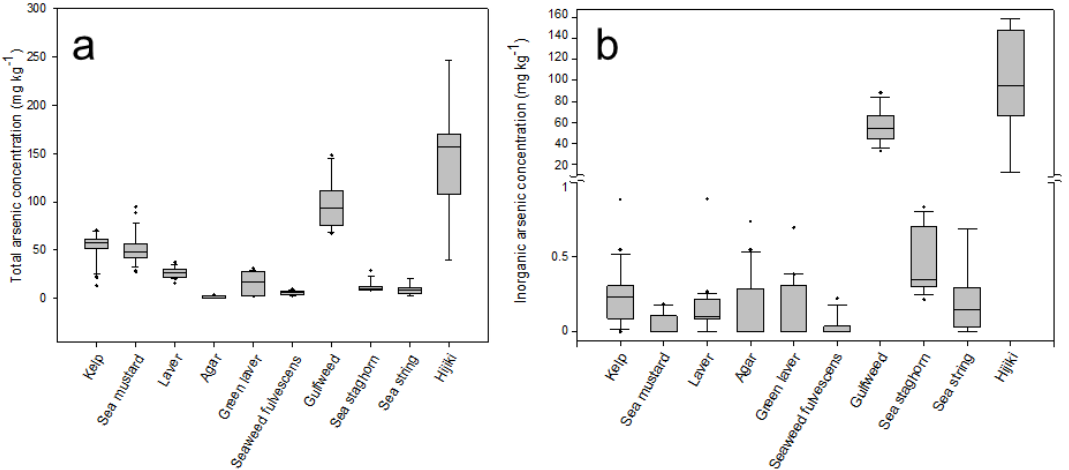
Figure 2. Boxplots of total and inorganic arsenic in seaweeds. Box and whiskers plot with central lines (median), box (first and third quartiles), whiskers (lower and higher boundaries), and dots (outliers) for total arsenic (tAs) ( a ) and inorganic arsenic (iAs) ( b ) levels in various types of seaweed analyzed in this experiment, three species of seaweed with higher daily consumption rates than other seaweeds (kelp, sea mustard, laver), and two species of seaweed with a high ratio of harmful iAs, as determined by the clustering analysis (gulfweed and hijiki) were assessed for risk. The small symbols represent outlier points in the figure.